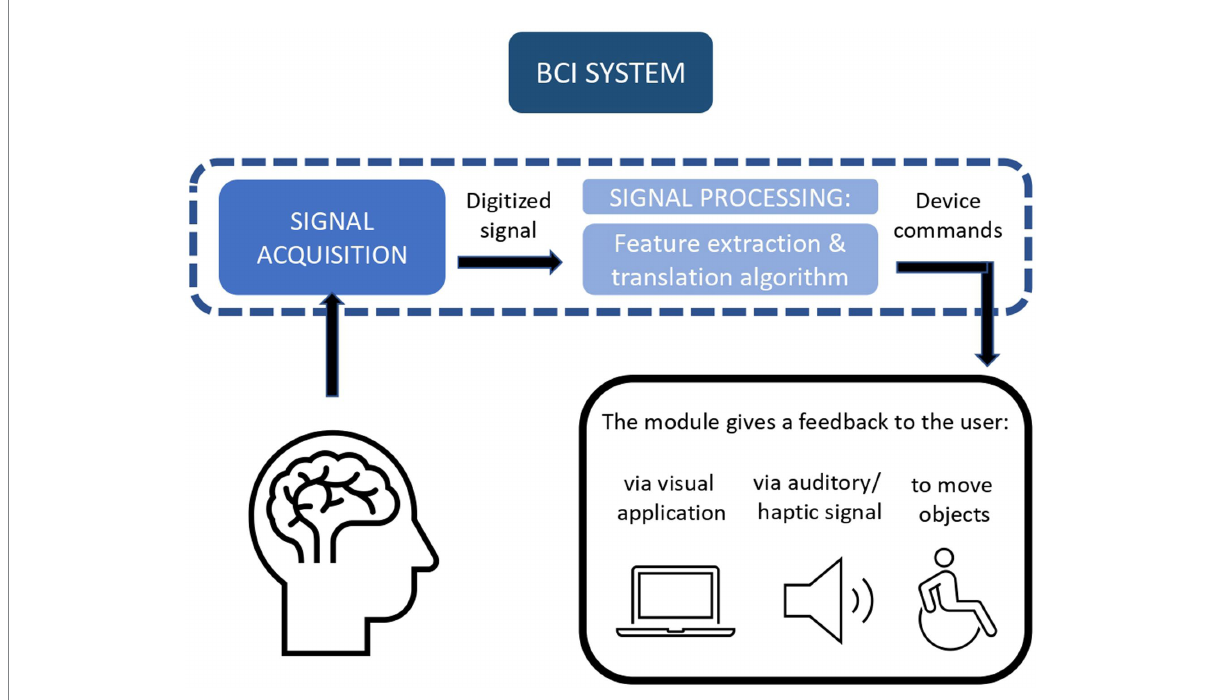
FIGURE 4 Brain-Computer Interface (BCI) system allows a loop communication between the brain and the